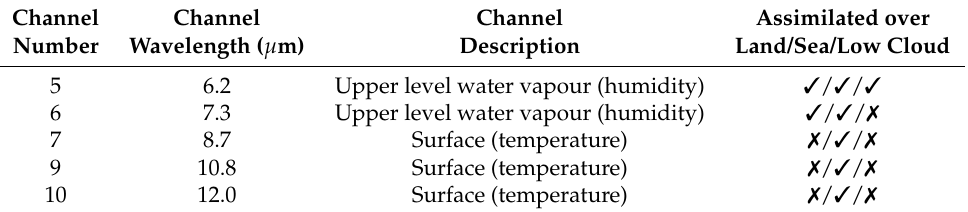
Table 1. SEVIRI Observation error